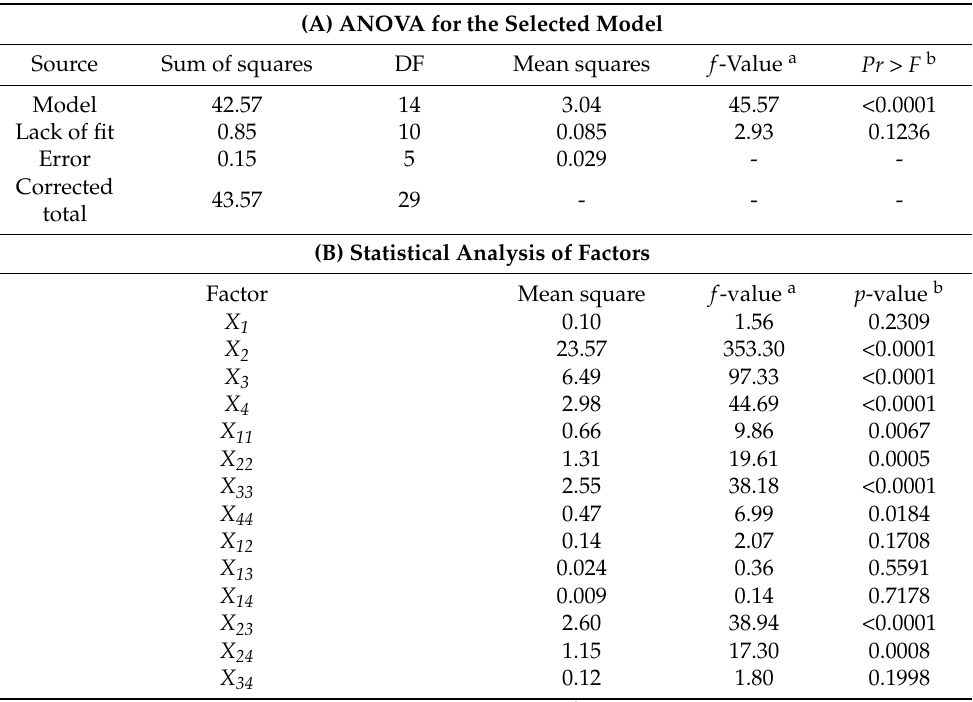
Table 3. Result of statistical analysis and analysis of variance (ANOVA) for response surface quadratic model.